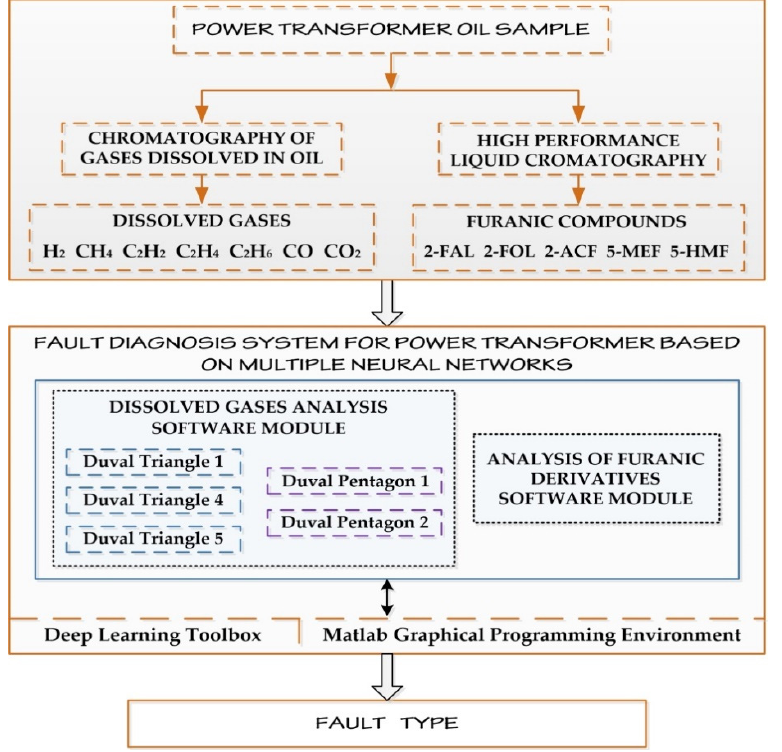
Figure 4. General scheme of the intelligent system for determining the faults of power transformers based on neural networks (ISDFPT-NN).